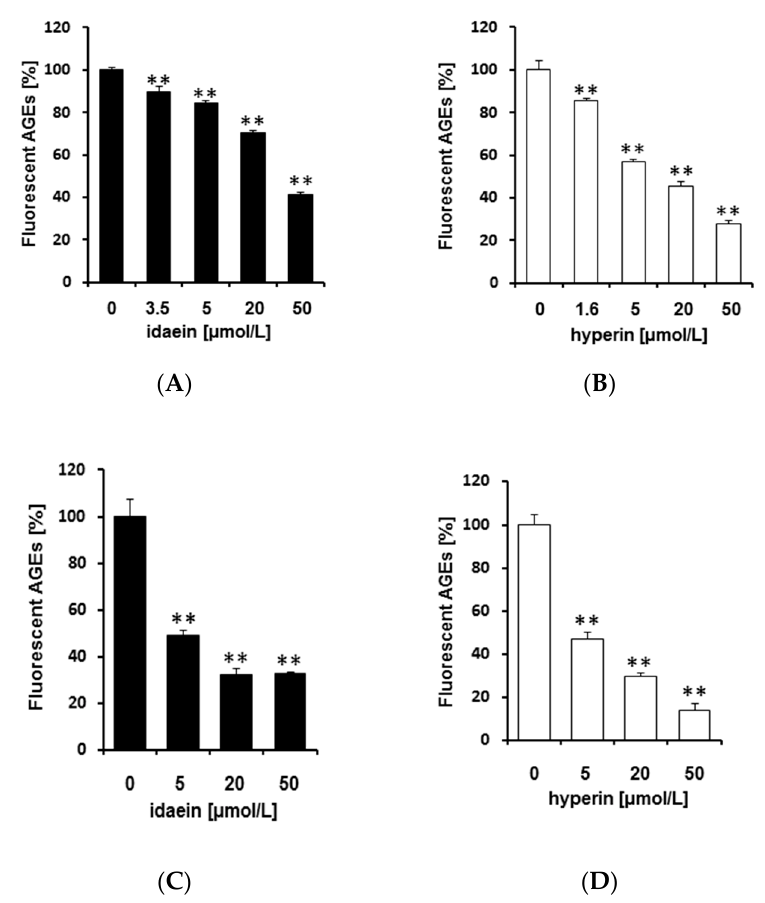
Figure 6. Efficacy of idaein and hyperin against formation of fluorescent AGEs. The indicated concentrations of authentic standards of idaein and hyperin were used to determine the inhibitory effect against formation of fluorescent AGEs in the ( A , B ) HSA glycation model and ( C , D ) type I collagen glycation model. After 40 h incubation at 60 ◦ C, fluorescent AGEs were measured at 370/440 nm. ** p < 0.01 vs. 0 µ